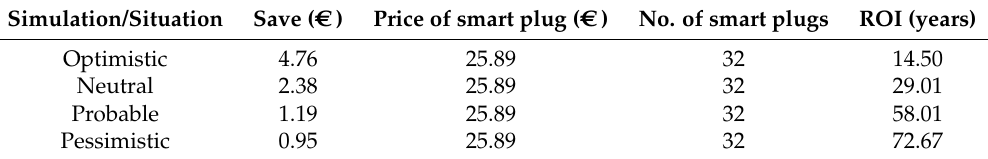
Table 5. Return on investment